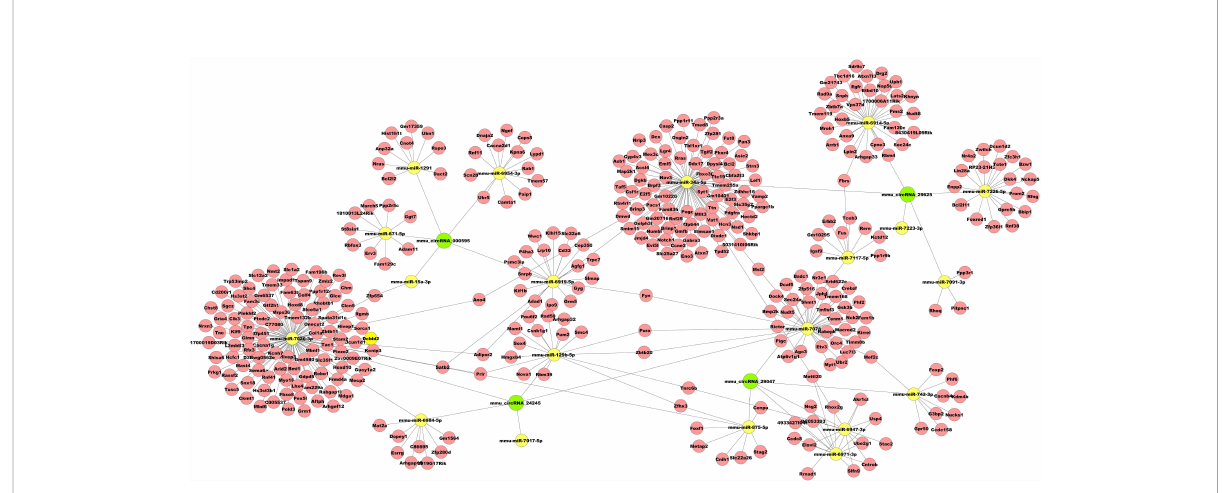
FIGURE 7 Representative circRNA-miRNA-mRNA network constructed by Cytoscape